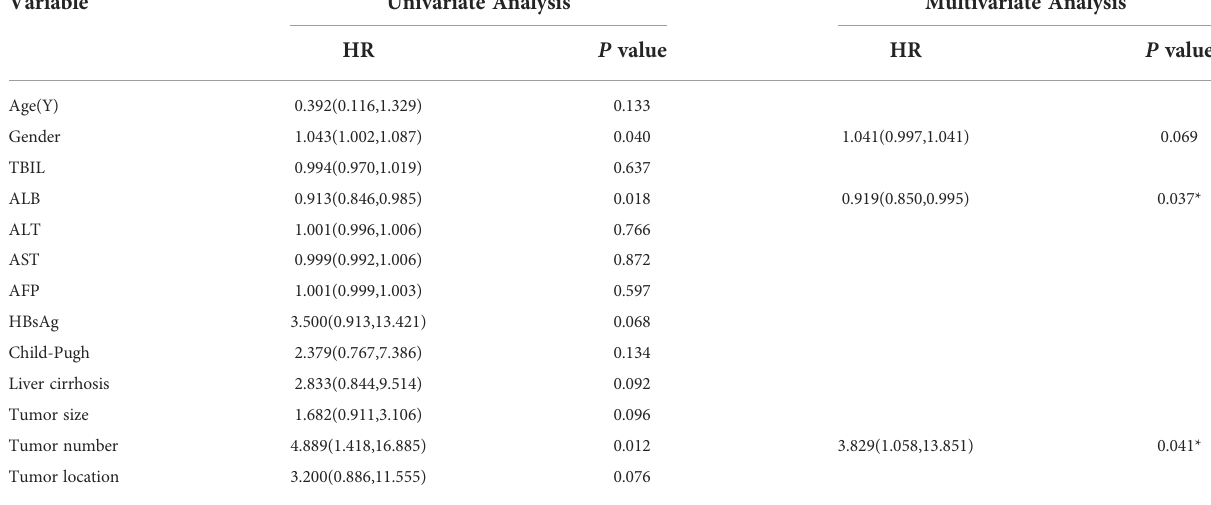
TABLE 2 Univariate and multivariate logistic regression analysis of risk factors for ER after RFA.